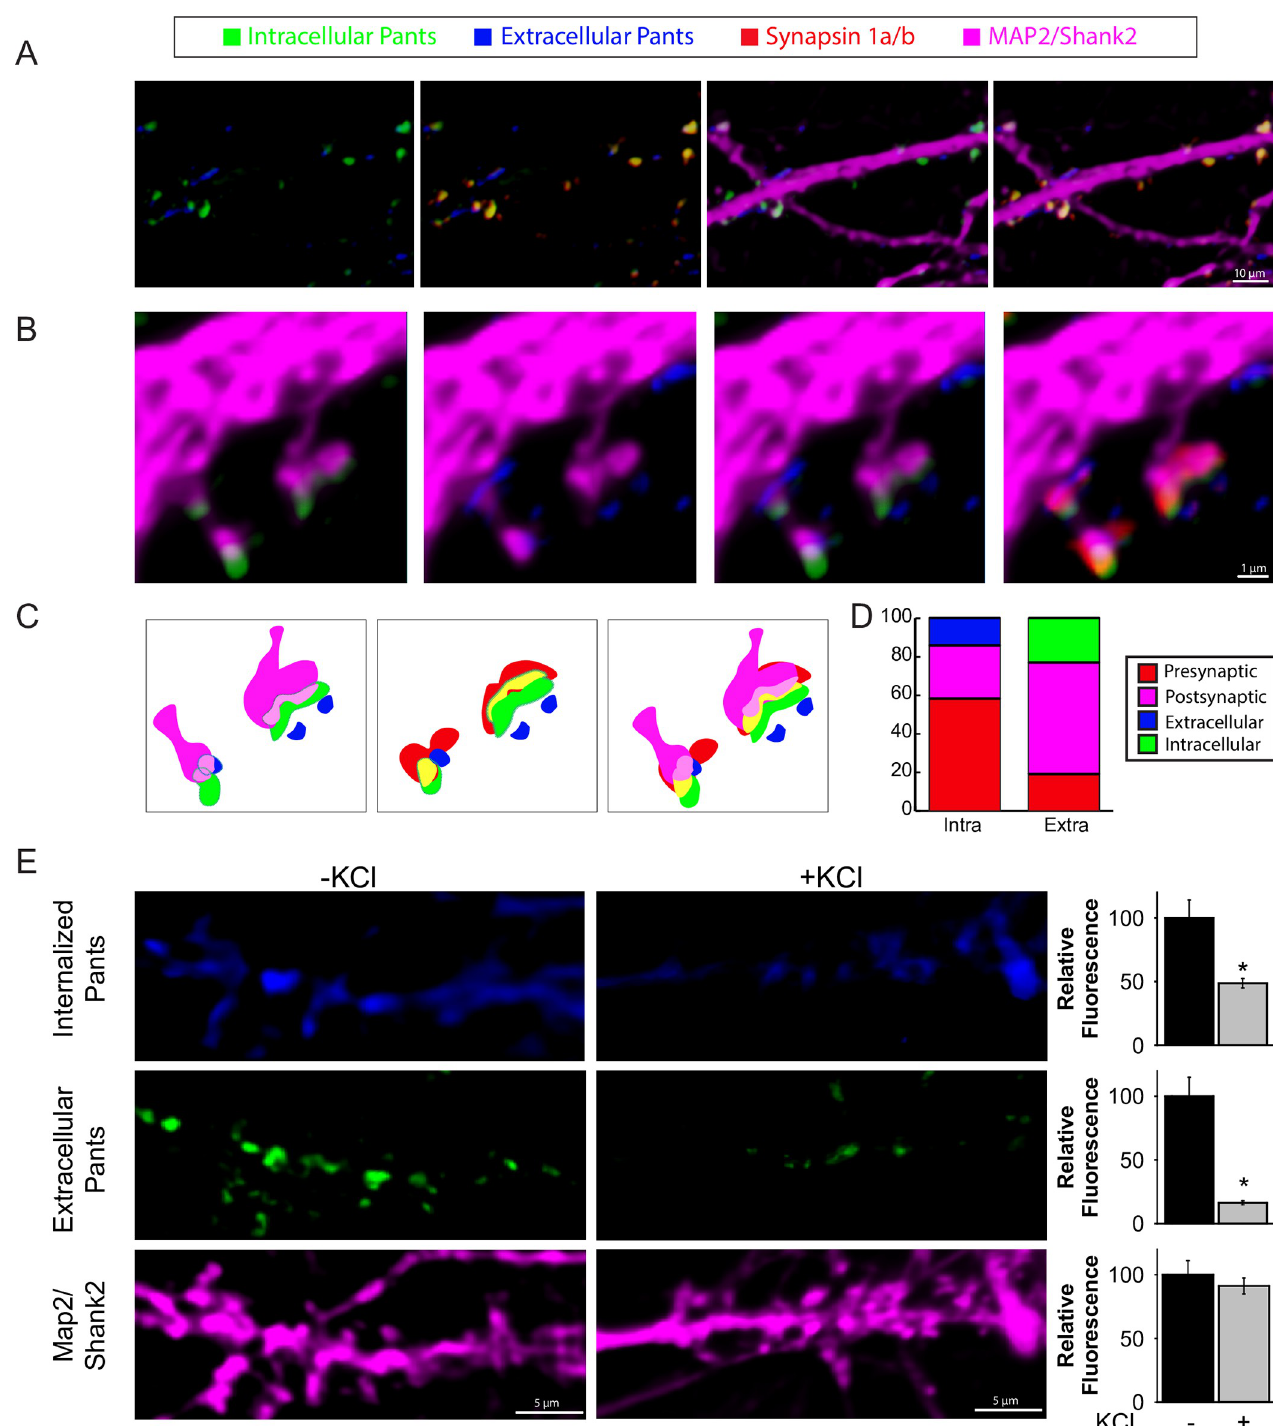
Fig 3. Extrasynaptic Pants is downregulated in response to neuronal activity. A) Contrasting extracellular/intracellular immunocytochemistry staining for HA in cultured hippocampal neurons. B-C ) Co-localization of intra- and extra-cellular Pants with synaptic markers D ) Quantification of Pants co-localization with pre- and post-synaptic markers correlation coefficients. E) Differentiated neuronal extracellular and internalized HA-Pants staining with and without 10 seconds 60mM KCl stimulation prior to fixation. Graphs at the right show quantification of HA fluorescence in dendritic ROIs, normalized to MAP2/Shank2 fluorescence. n = 3 P < 0.001(extracellular) and P = 0.005 (internalized)P values generated by Mann-Whitney Rank Sum test.